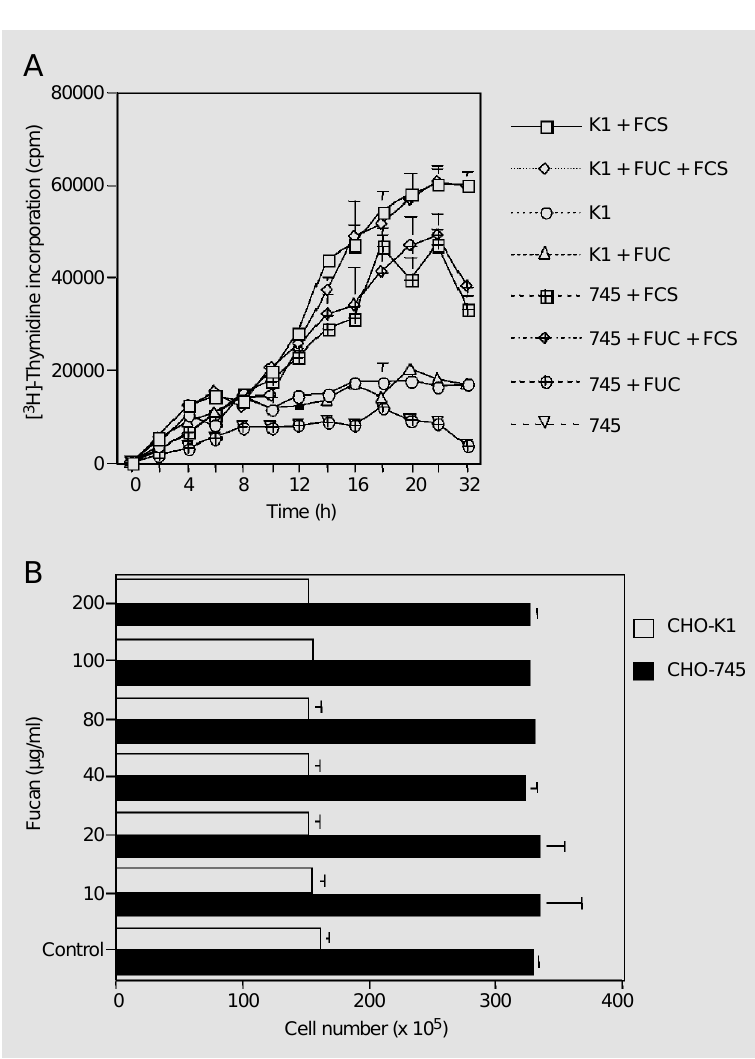
Figure 1. Thymidine incorporation and proliferation of CHO cells in the presence of fucan B from Spatoglossum schröederi. A , Thymidine incorporation into CHO cells in the presence of fucan. CHO cells were maintained in F-12 medium supplemented with 10% FCS at 37 o C, 2.5% CO 2 . For the incorporation of [ 3 H]-thymidine, quiescent cultures were incu- bated with [ 3 H]-thymidine (0.25 µCi/ml) for the times indicated and radioactivity was determined by scintillation counting. Data are reported as the mean ± SD of four determi- nations. FUC - Fucan B. B , Effect of different fucan concentrations on the growth of CHO cells. Growth-arrested cells were released from the G 0 phase by the addition F-12 medium plus 10% FCS in the absence (control) or in the presence of the indicated concentrations of fucan. The initial cell number was 3 x 10 5 cells/plate. After incubation at 37 o C for 5 days in a 2.5% CO 2 atmosphere, the cells (in triplicate plates) were harvested after “viocase” treatment and cell number was determined. Values are reported as the mean ± SD of triplicate